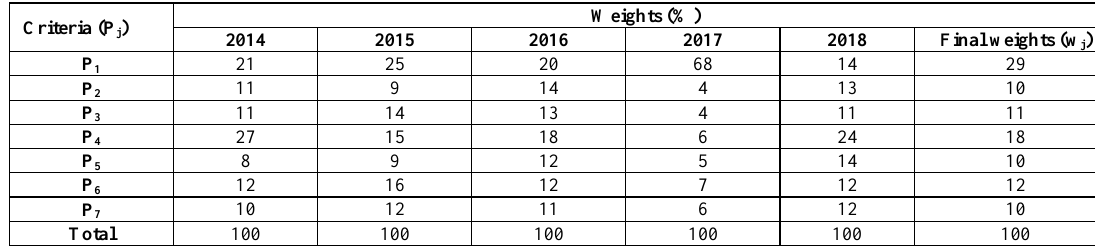
Table 2. Objective weights for performance